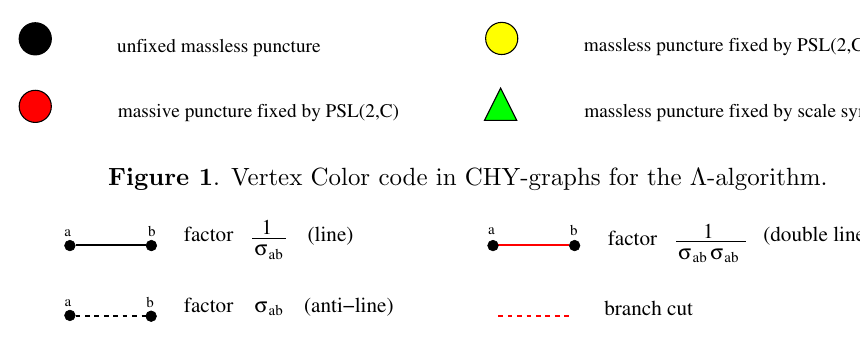
Figure 2 . Edges Color code in CHY-graphs for the